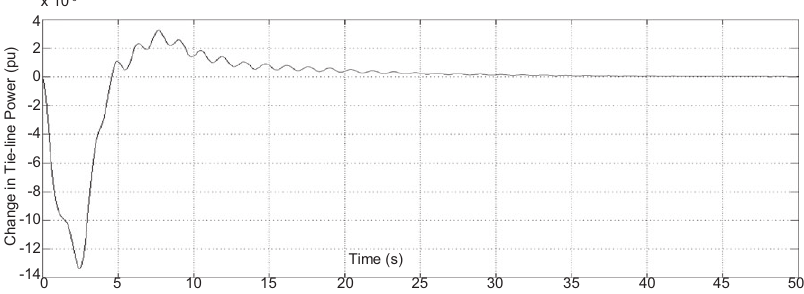
Figure 16. Change in Tie-Line Power (Hydro-Thermal Plant): With ANN Controller.